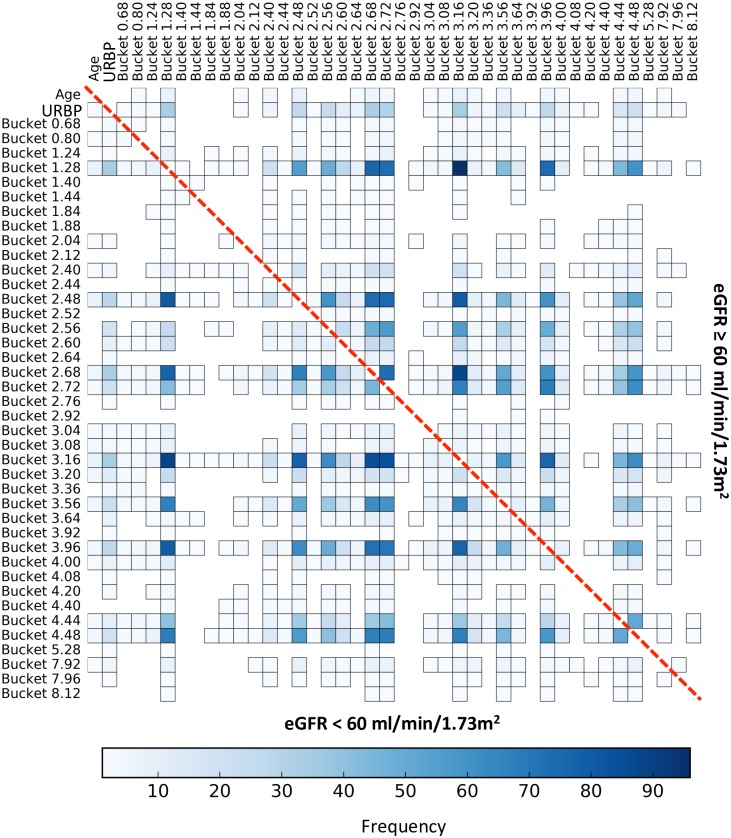
Frequency of the bucket interaction over the 100 multi-source local 1&2D models.This figure shows the frequency heatmap (color scale) of the interactions of each multi-source variable pair over the 100 local 1&2D models. The more robust the interaction, the darker it will be. The interactions corresponding to the subgroup of patients with an eGFR < 60 ml/min/1.73m2 are displayed in the lower triangle and conversely, the interactions corresponding to the subgroup of patients with an eGFR ≥ 60 ml/min/1.73m2 are displayed in the upper triangle. The limit of the two triangles is represented by the red dashed-line.